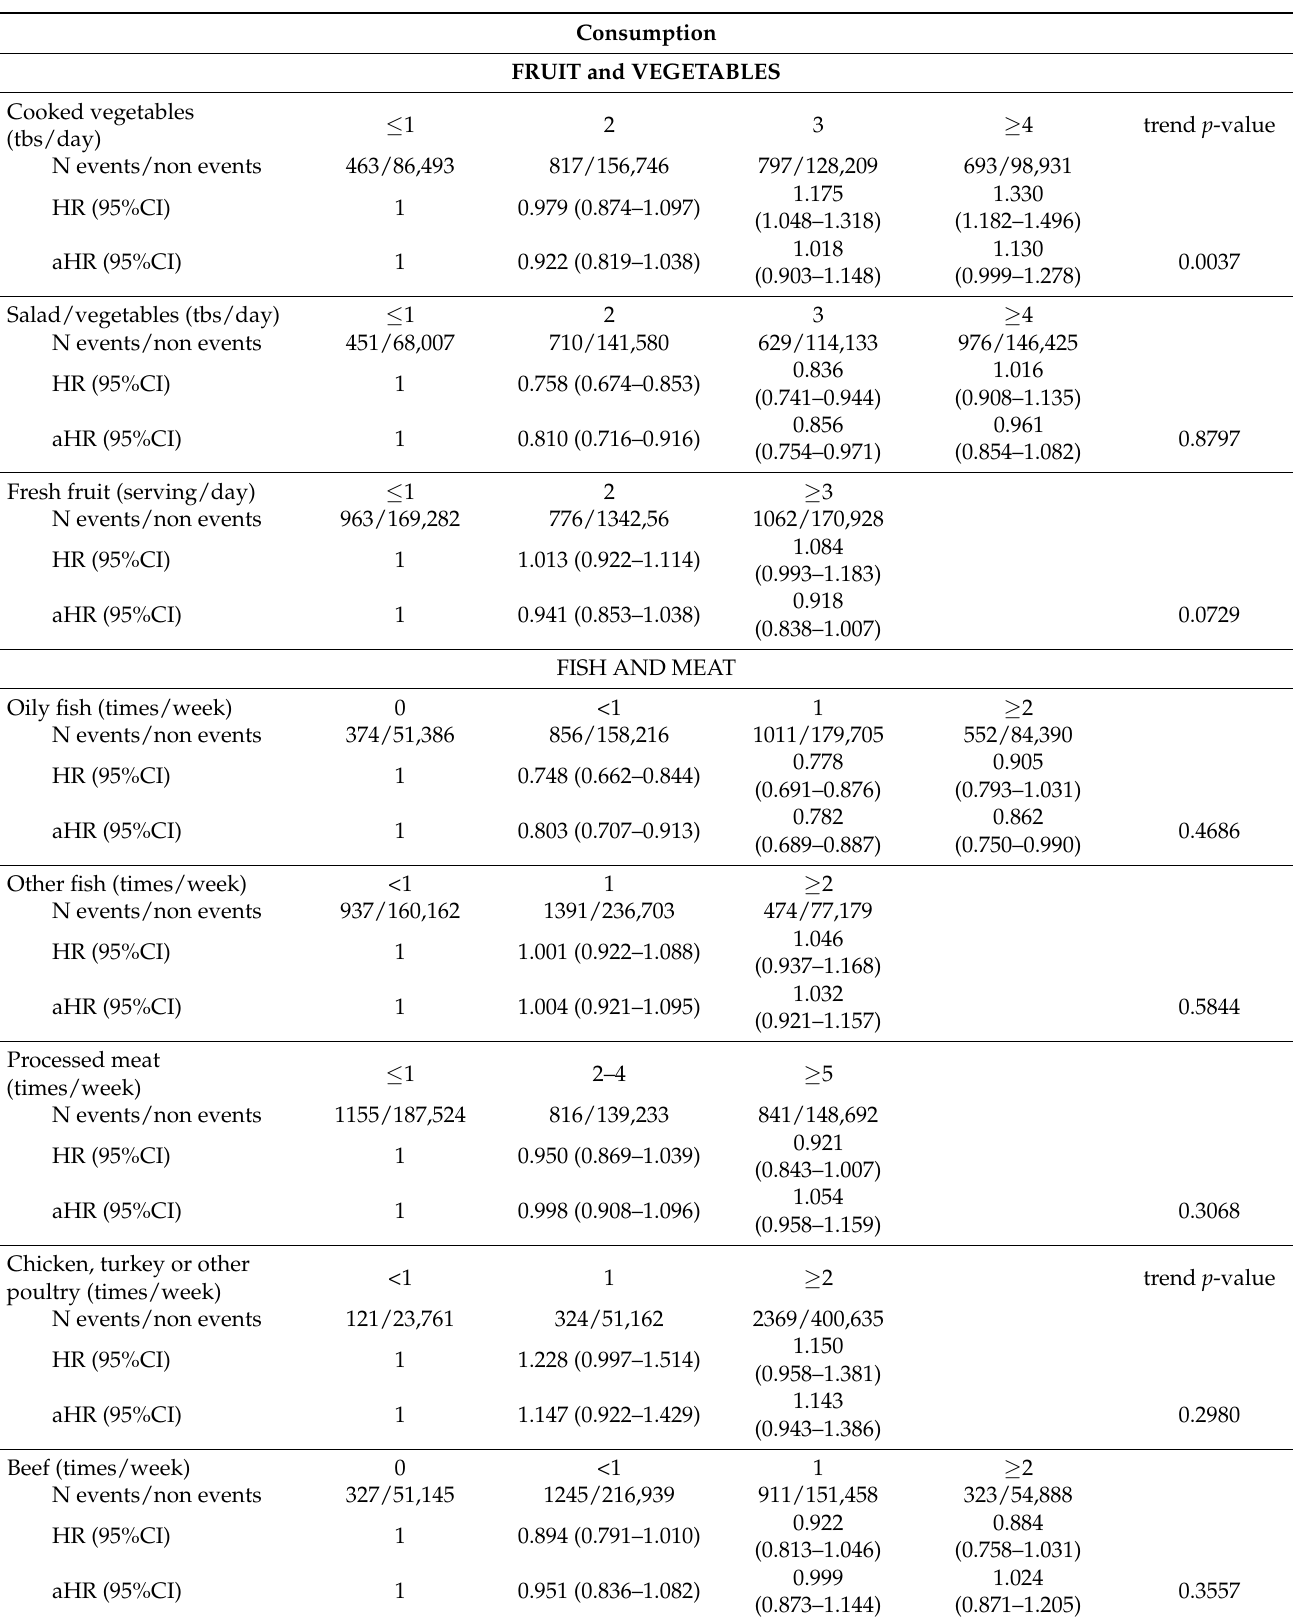
Table 2. Distribution of the diet components, unadjusted and adjusted hazard ratios (HR) and corresponding 95% confidence intervals (CI) for the association with RA and p -value of the trend test. Consumption FRUIT and